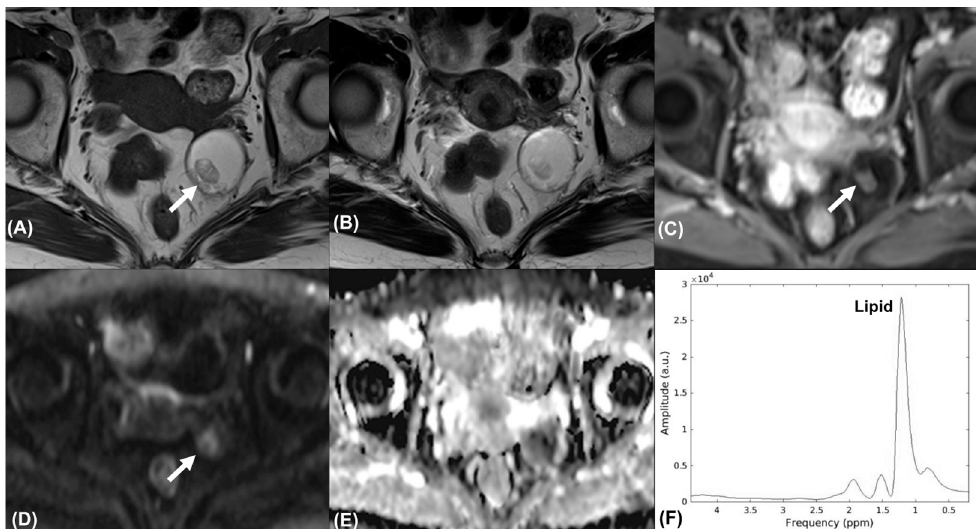
Figure 2. Mature cystic teratoma in a 67-year-old woman. Axial ( A ) T1-weighted, ( B ) T2-weighted, and ( C ) contrast-enhanced T1-weighted MR images show a left adnexal cystic mass with fatty content. Axial ( D ) high- b -value DW image ( b = 1000 s/mm 2 ) and ( E ) ADC map demonstrated mild restricted diffusion of the solid nodule ( arrow ). The tumor was classified as an O-RADS 3 lesion. ( F ) MR spectroscopy depicts prominent resonances corresponding to lipids (demonstrated using the FID-A toolkit